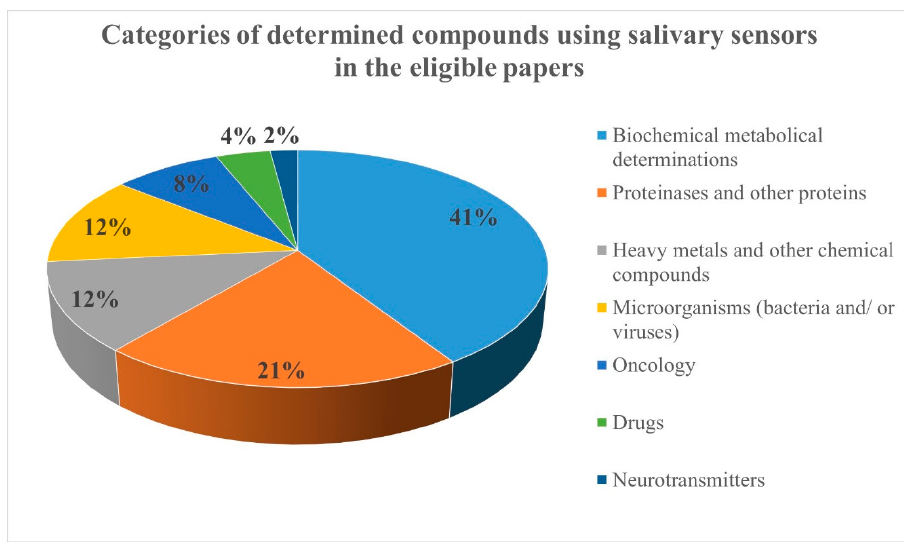
Figure 2. The categories of determined compounds using salivary sensors in the eligible papers.